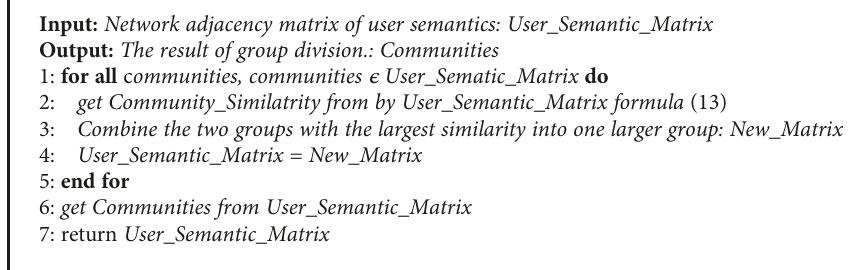
Algorithm 6: Division of network groups of semantic construction of Tibetan Weibo